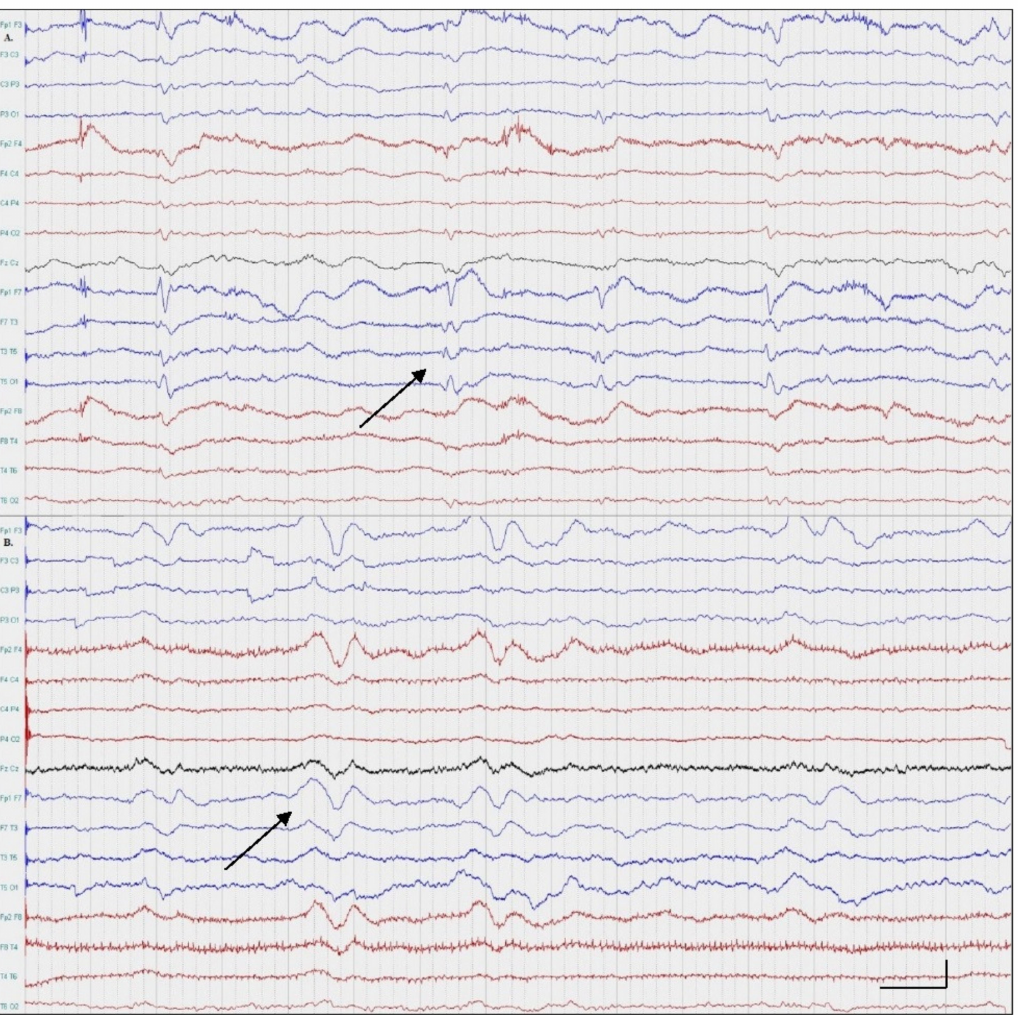
Figure 2. EEGs: Patient Two. ( A ) Continuous periodic epileptiform discharges over the left temporal region; ( B ) very frequent polymorphic theta and delta slow wave activity over the left hemisphere (double banana montage, 0.3–70